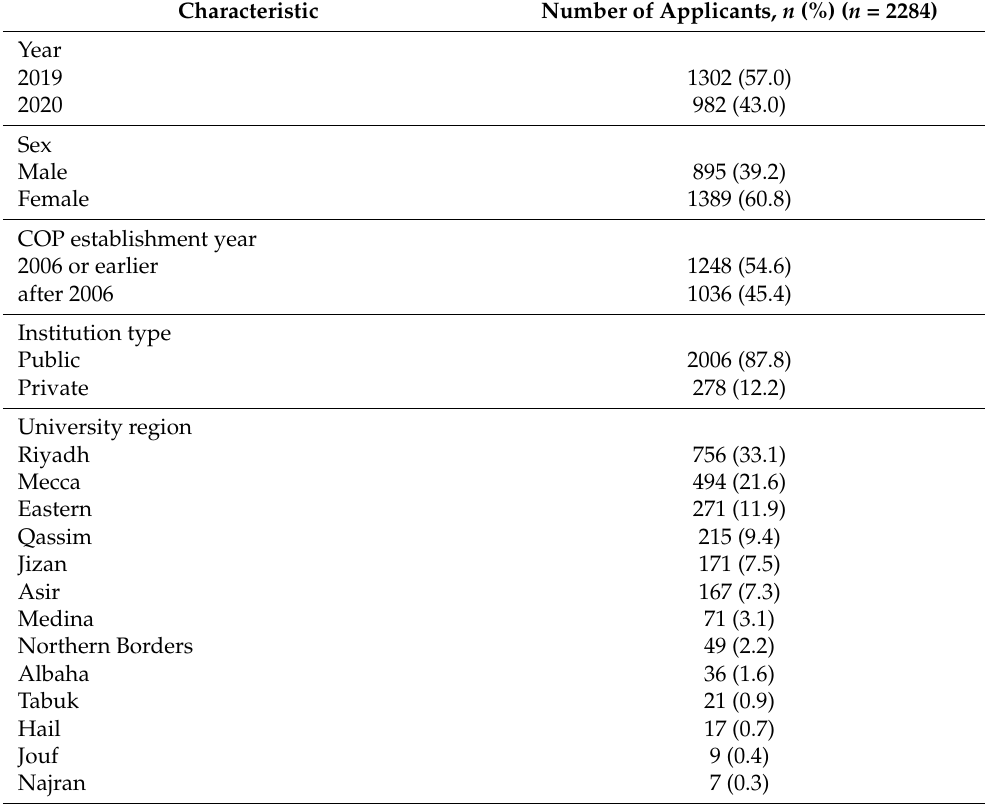
Table 1. Characteristics of first-time SPLE applicants during 2019 and 2020.